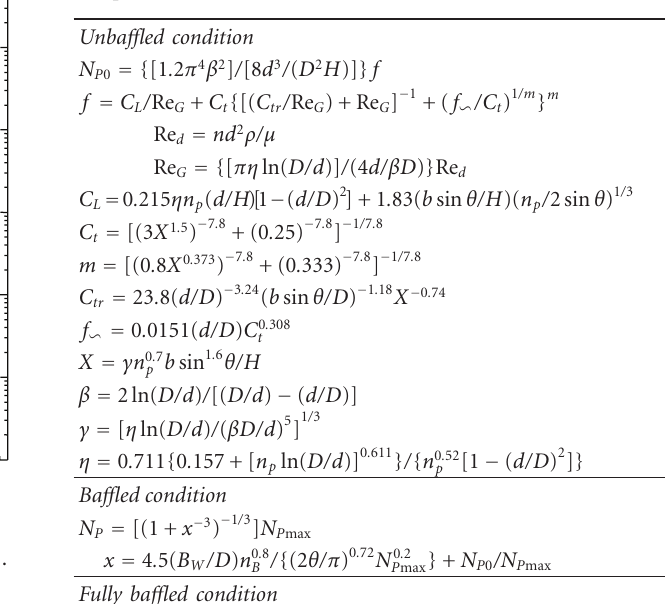
Table 3: Correlation equations of power number for propeller (d) and pfaudler (f).